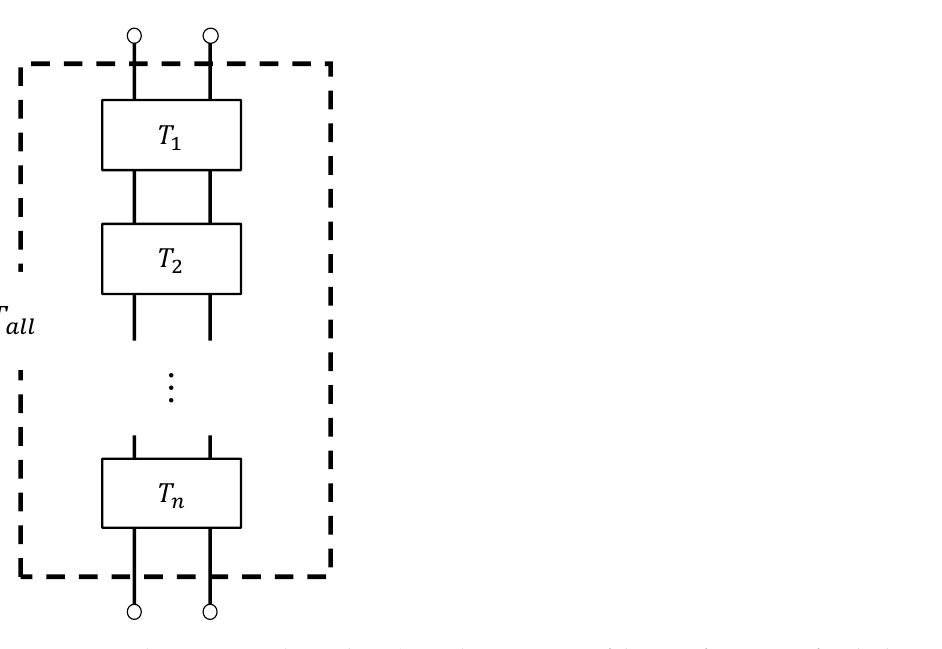
Figure 9. Equivalent circuit in the analysis (cascade connection of the transfer matrix of each ele- ment).